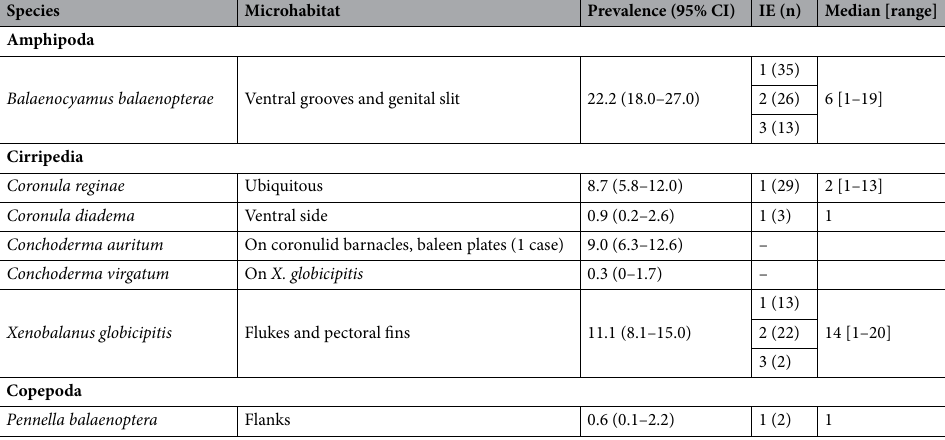
Table 2. Infestation parameters and microhabitat of the epibiotic fauna found on Antarctic minke whales, Balaenoptera bonaerensis , in the Southern Ocean. ‘IE’ is an Intensity Estimate where 1 stands for 1–20 specimens, 2 for 21–100, and 3 for 101–500; ‘n’ is the number of whales included in each category. The median number and range are provided whenever IE = 1. In the case of Conchoderma spp., IEs were not obtained.